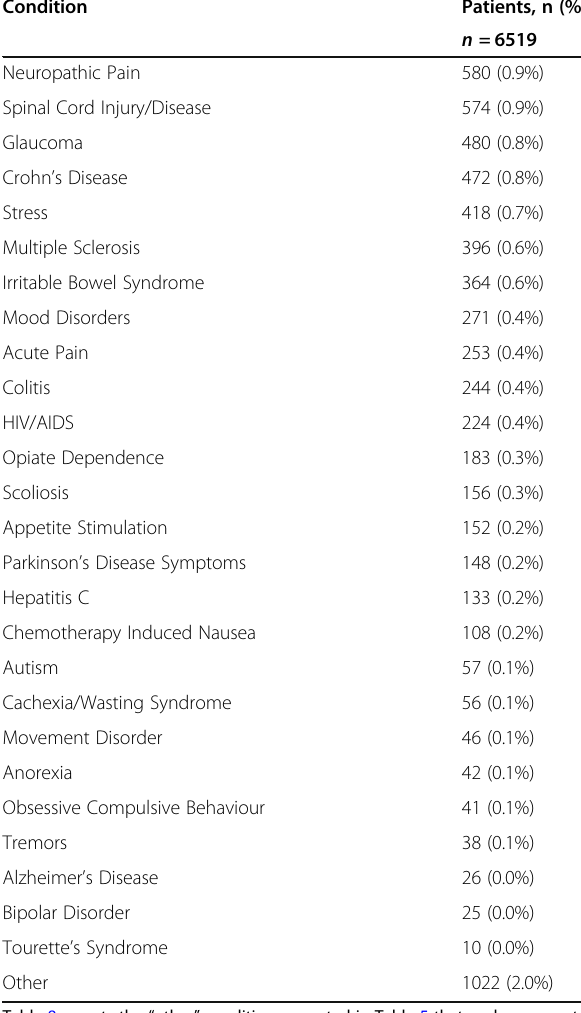
Table 8 Summary of “ other ” conditions each representing less than 1.0% of the total sample of patients seeking medical cannabis